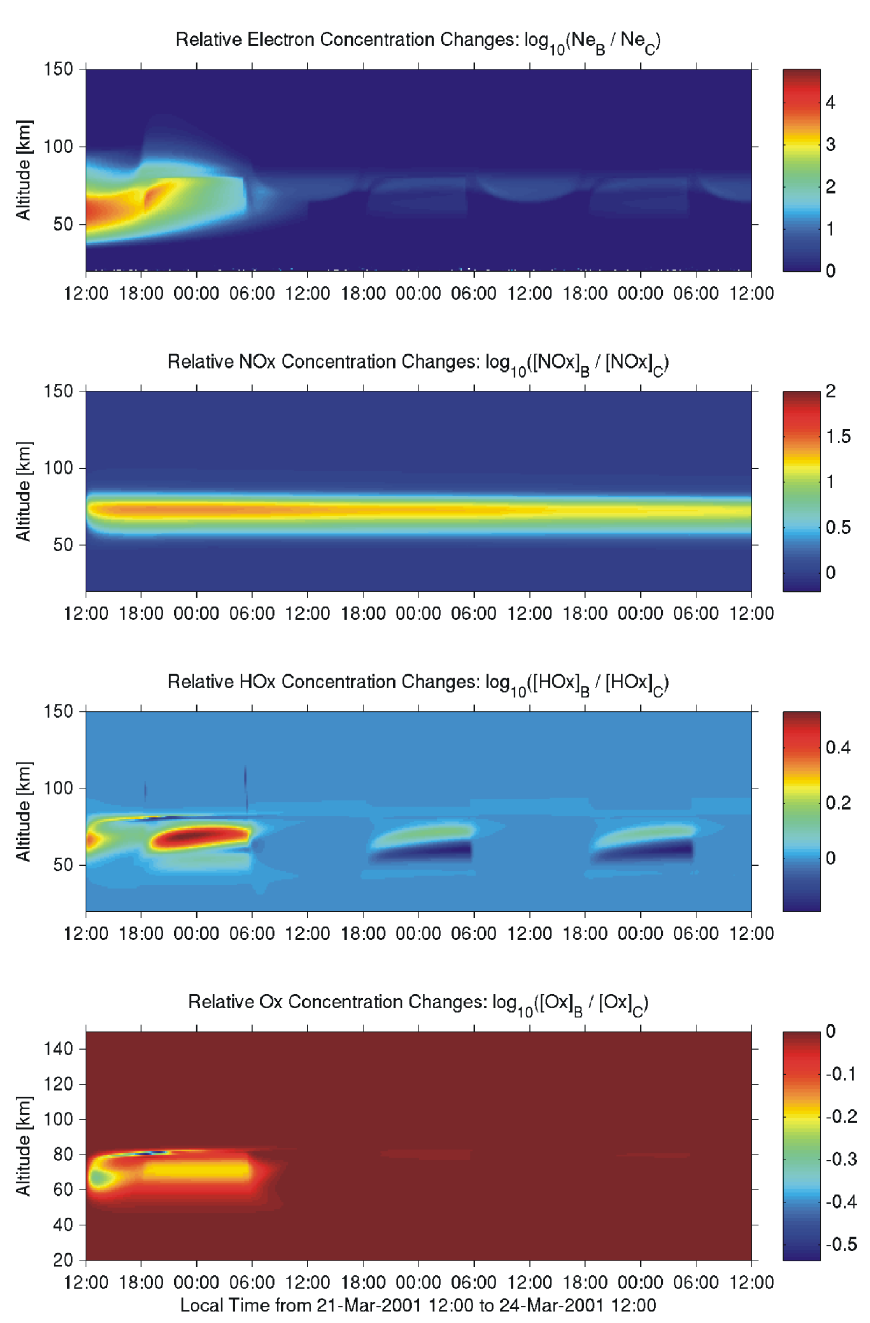
Fig. 5. The effect of the RBR-forced precipitation starting at 12 LT as calculated using the SIC model, due to the precipitating fluxes shown in Fig. 4. The top shows the RBR-forced (”B”-run) change in electron densities, relative to normal conditions (”C”-run), while the lower panels show changes in NO x and O x